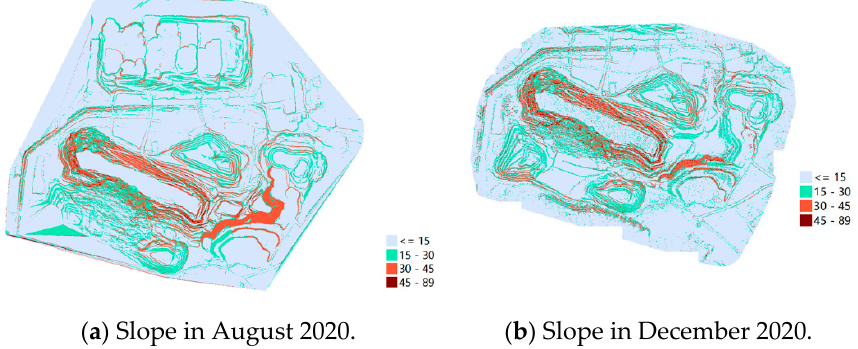
Figure 4. Slope of Pit 4 in August 2020 and December 2020.